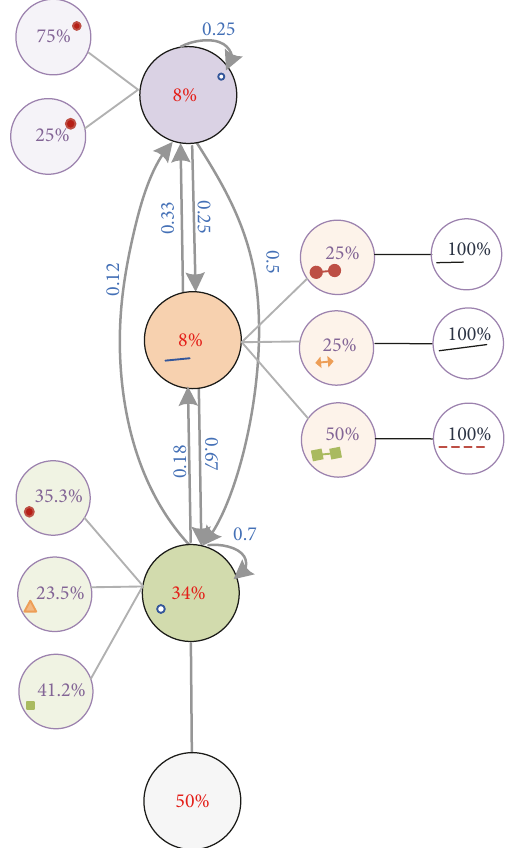
Figure 11: Individual travel behavior graph of passenger P4.